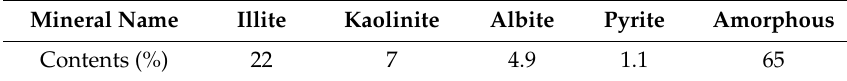
Table 2. Mineral composition of the Longtan coal